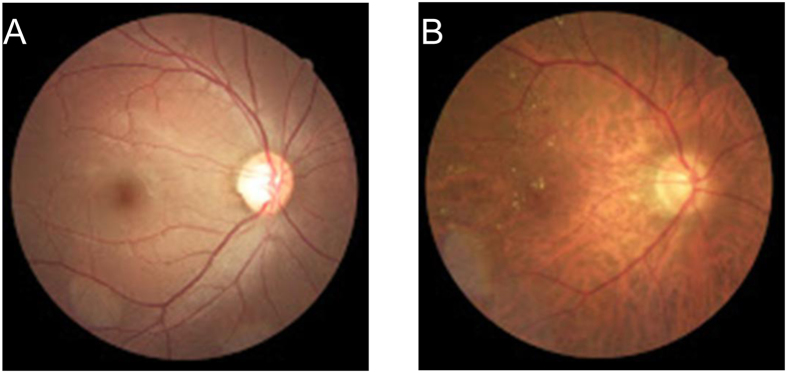
Color fundus photograph.(A) a normal pregnant women at 36 weeks of pregnancy, ocular fundus photography showed normal retinal structure; (B) a woman with severe preeclampsia 13 days after cesarean section, ocular fundus photography showed macular edema with striae and yellowish opaque retinal lesions.